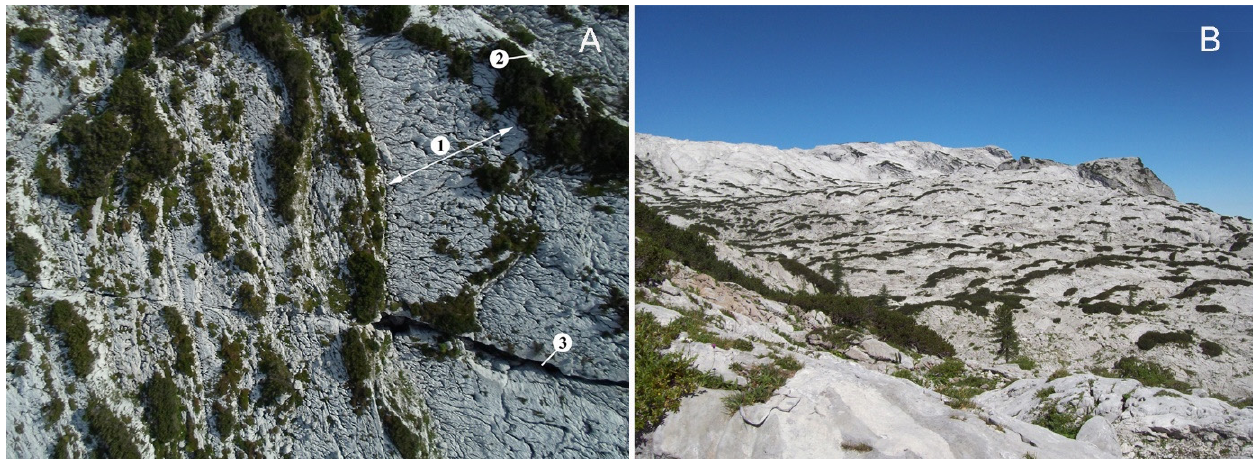
Figure 6. “Schichtreppenkarst” ( A ) and “Schichtrippenkarst” ( B ) according to Bögli [46], horizontal beds on A (aerial photograph), inclined beds on B (Totes Gebirge, Austria). Legend: 1. bedding plane with rinnenkarren, 2. scarp front, 3. giant grike. (Photographs taken by Márton Veress).